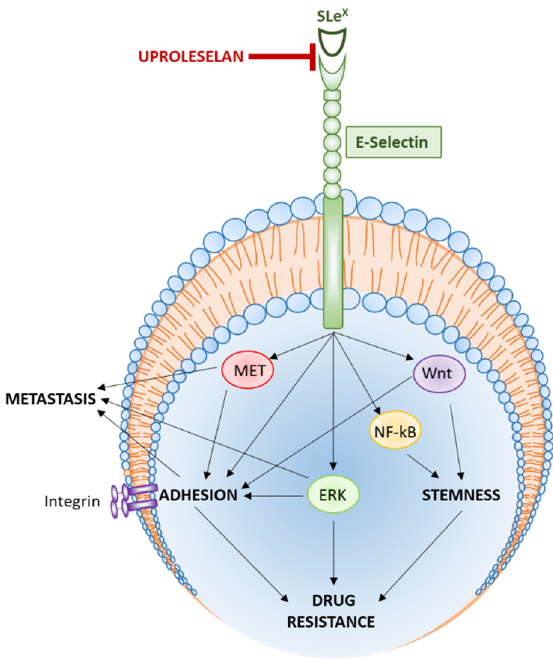
Figure 2. Mechanism of action of uproleselan.